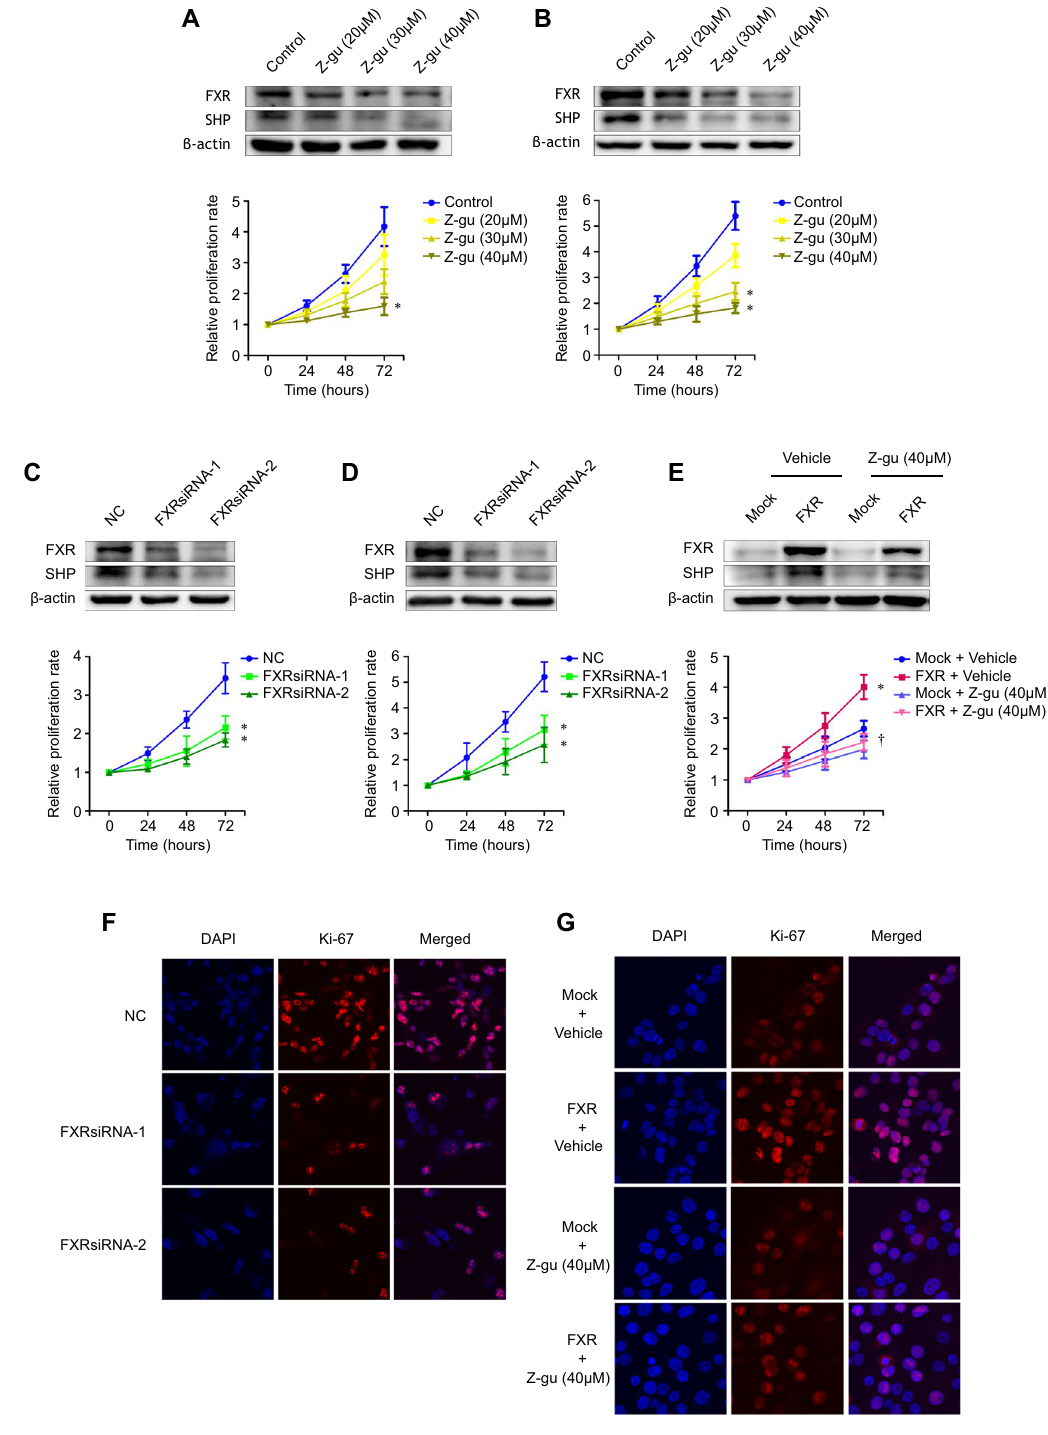
Figure 2. FXR promotes the proliferation of NSCLC cells in vitro . H1975 and H1299 cells were treated with Z-guggulsterone (Z-gu, 20, 30, and 40 μ M) ( A and B ), or were transfected with NC- or FXR-siRNA sequences ( C and D ). HCC4006 stable cell lines were treated with Z-guggulsterone (40 μ M) ( E ). The FXR and SHP protein expression levels in each cell line were determined by western blot two days later (upper graph). Cell proliferation was determined after the indicated treatment by using SRB assay at different time points (lower curve). Representative images of immunofluorescent staining of Ki-67 in H1975 cells transfected with NC- or FXR-siRNA sequences ( F ), and HCC4006 stable cell lines treated with Z-guggulsterone (40 μ M) ( G ) at × 60 magnification. The nuclei were stained with DAPI. All experiments were repeated at least three times. * p < 0.05, compared with the control, NC, or mock group, respectively; † p < 0.05, compared with the FXR-overexpressed HCC4006 cell